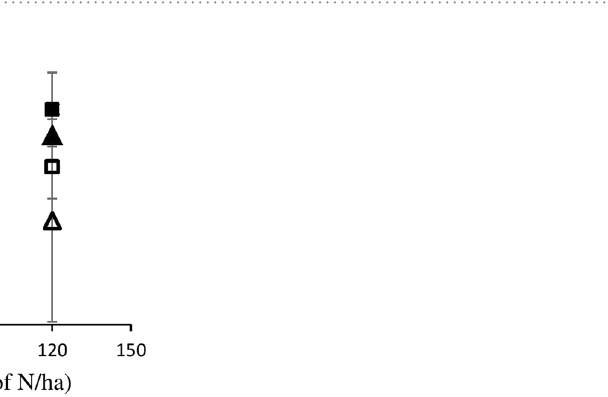
Table 2. Maize grain yields (q/ha) after inoculation (I) and no inoculation (NI) of seeds with A . lipoferum CRT1. Sub-plots received no nitrogen fertilization in the four fields (FC, L, C, Corg) during the two years of the study. Grain yields are expressed in q/ha. Letters a/b above numbers refer to significance classes at p < 0.05 after two-by-two comparisons between PGPR-inoculated and mock-inoculated conditions (n = 5). Non-parametric Wilcoxon tests were run using blocs as a random variable.